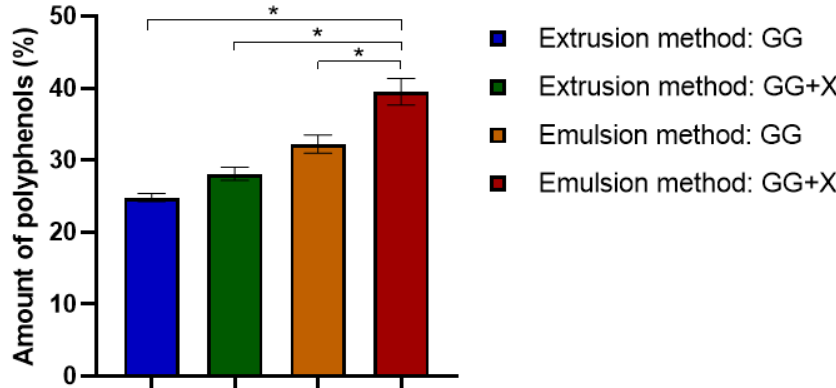
Figure 3. Loading capacity of microspheres based on gellan gum and gellan gum with xanthan gum mixtures. ANOVA-one way with Tukey’s post-hoc analysis (Cl = 95%) was performed to statistically